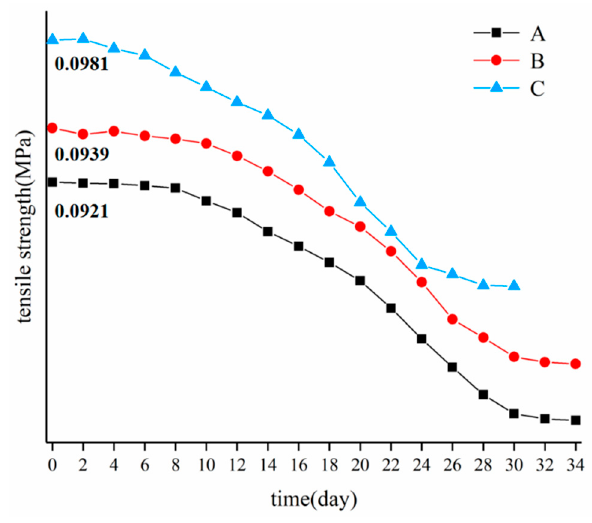
Figure 8. Tensile strength of banana stem sheath.